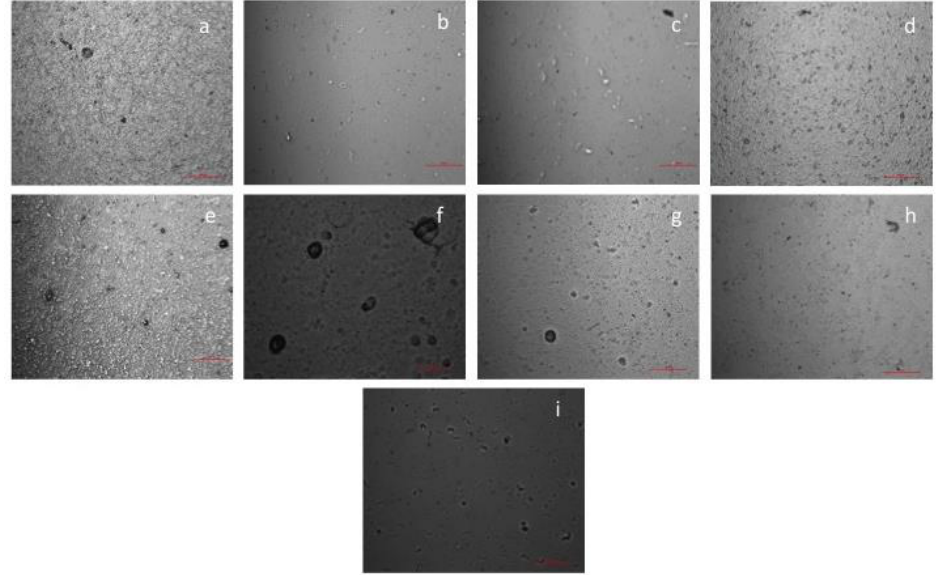
Figure 1. Surface micrographs of the edible films (red line 500 µ m): ( a ) S 1 ; ( b ) S 2 ; ( c ) S 3 ; ( d ) S 4 ; ( e ) S 5 ; ( f ) S 7 ; ( g ) S 8 ; ( h ) S 9 ; ( i ) S